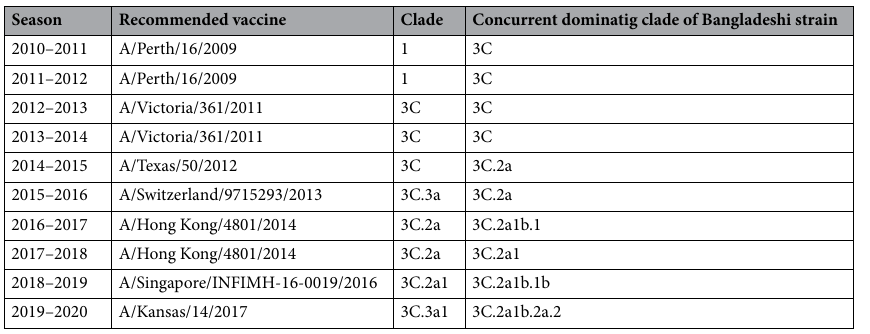
Table 1. The clade of WHO recommended H3N2 vaccine strains and concurrent most dominant strains detected in Bangladesh.